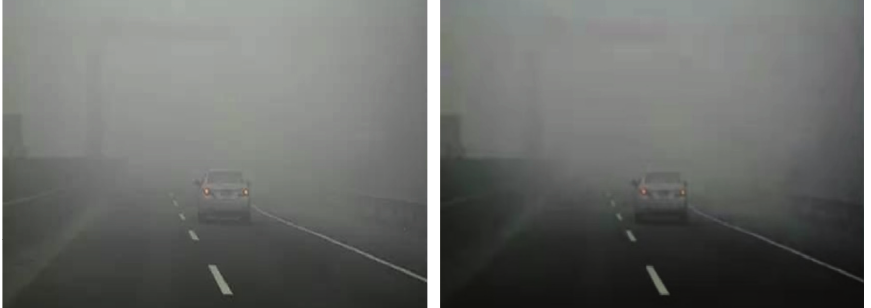
Figure 8: Denoising effect.